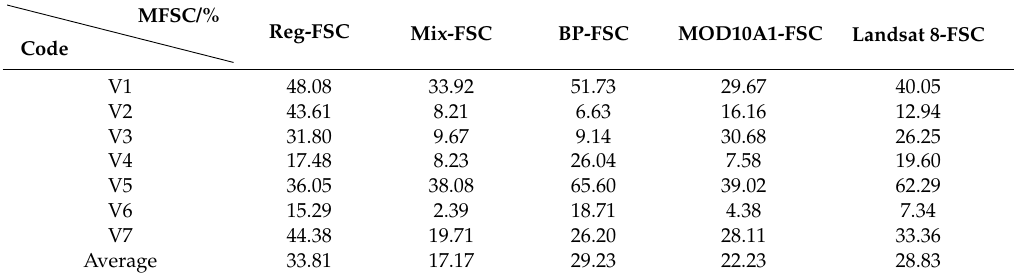
Table 5. MFSC statistics for the three FSC models and the MOD10A1 FSCs in the validation sub-regions (V1–V7).